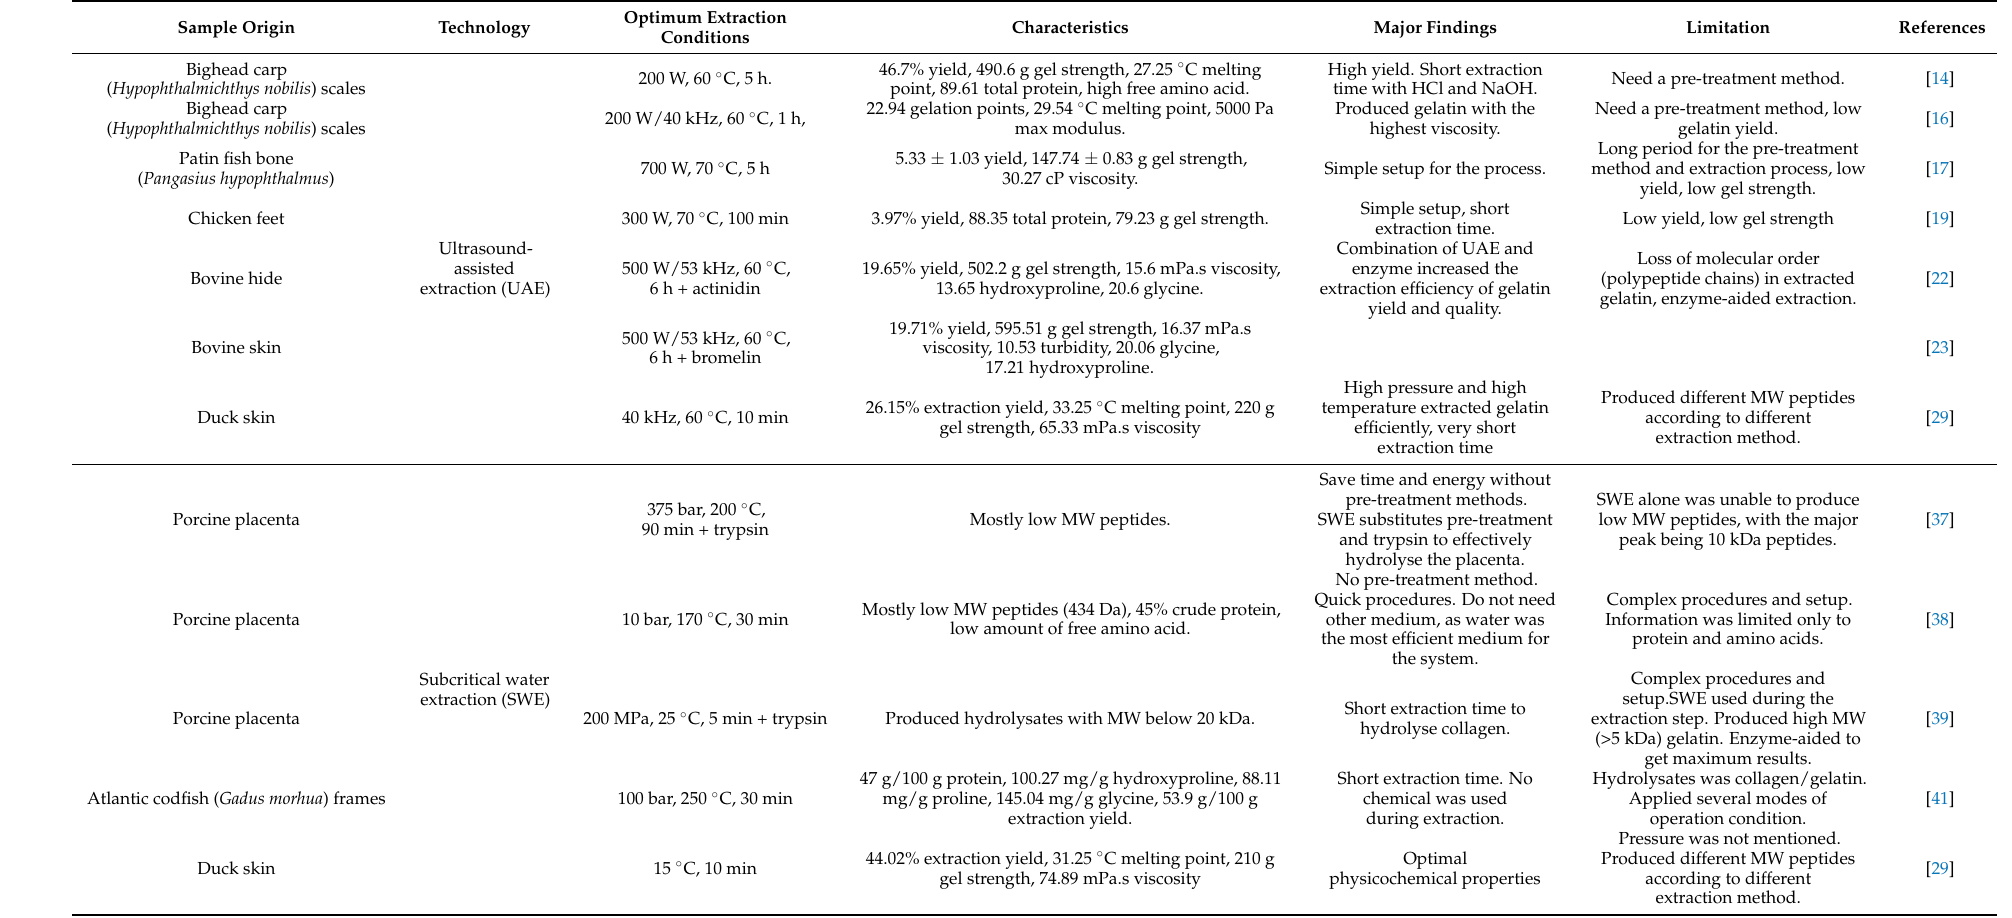
Table 2. Characteristics of gelatin using green-technology extraction from various